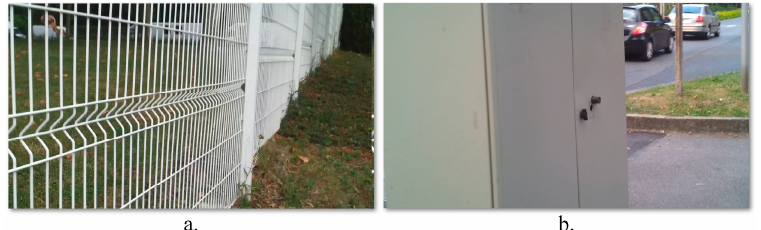
Figure 11. Detected objects missed: ( a ) By the ultrasonic sensor system; ( b ) By the computer vision system.